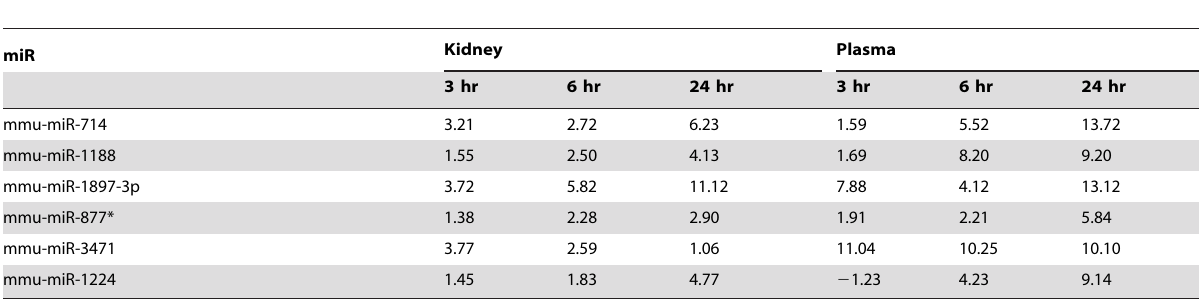
Table 2. MicroRNAs concordantly modulated in kidneys and plasma (pooled sample results).